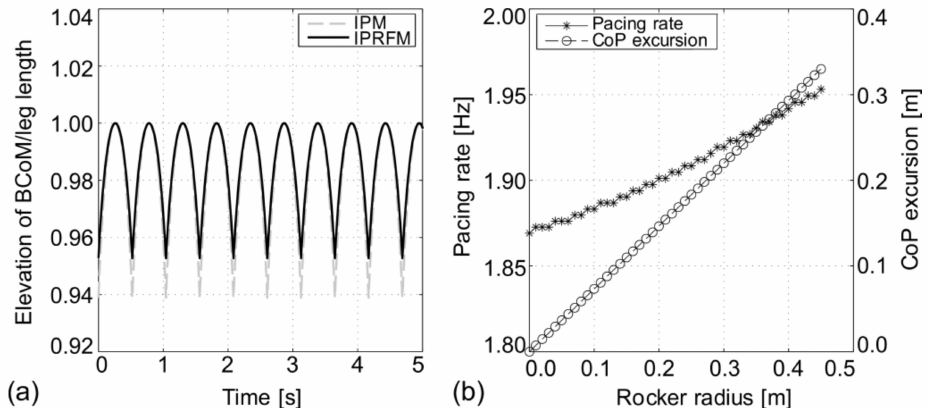
Figure 11. ( a ) Trajectory of the BCoM in the IPM and IPRFM: m p = 77.5 kg, l + r = 1.037 m ( r = 0 m in IPM, r = 0.3 m in IPRFM). ( b ) Pacing rate and the CoP excursion as functions of the rocker radius: m p = 77.5 kg, l + r = 1.037 m. In all simulations: θ 0 = 69 ◦ and